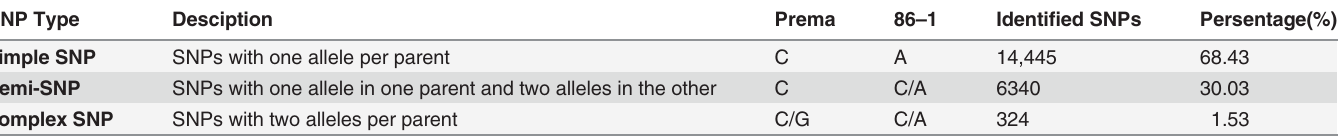
Table 2. Identified putative SNPs classified by SNP